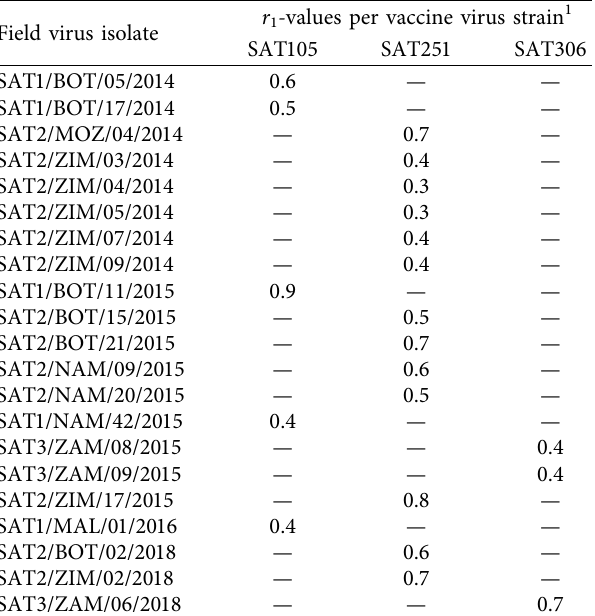
Table 2: Vaccine matching results on some field FMD viruses isolated from cattle originating from various countries of southern Africa during the period 2014–2018. Field virus